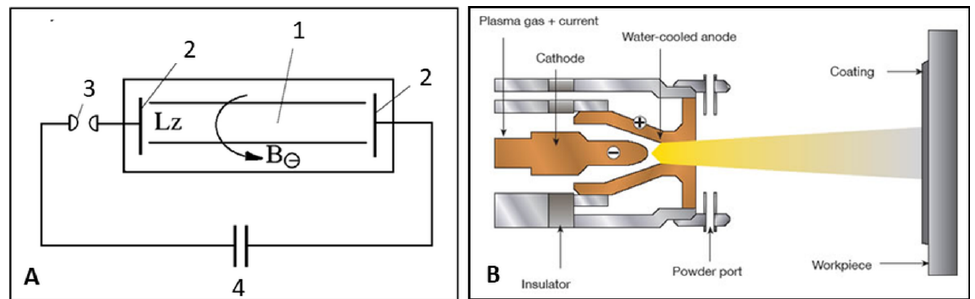
Figure 1. Design of plasmatron. ( A ): Schematic representation of a z-pinch apparatus. 1. plasma column, 2. electrodes, 3. arc gap, 4. capacitor battery. ( B ): Typical plasmatron configuration for atmospheric plasma spraying. © Creative Commons CC BY-NC-ND 4.0.